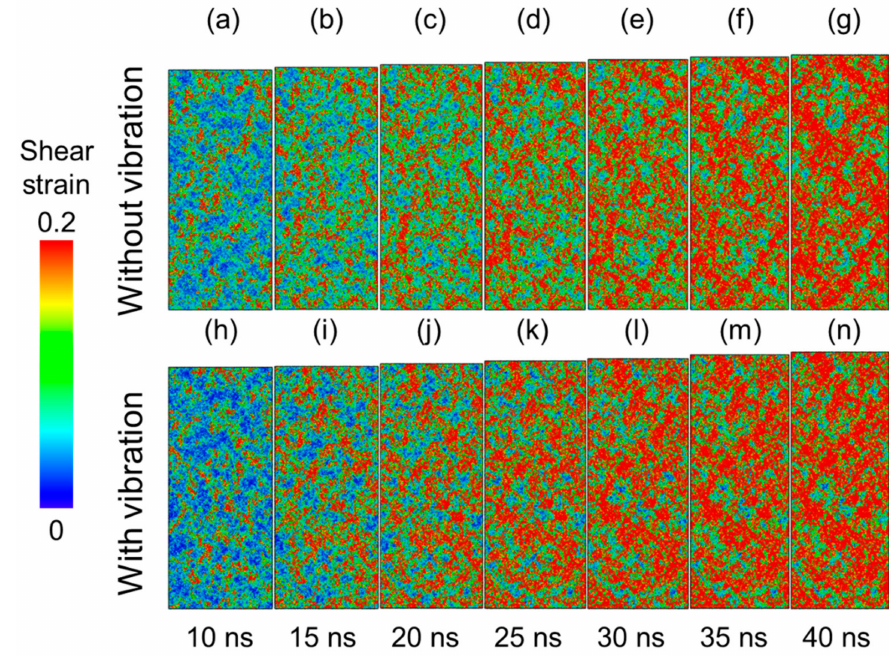
Figure 3. Distribution of shear transition zone (STZs) during the uniaxial tension of MG, ( a–g ) without vibrational loading and ( h–n ) with vibrational